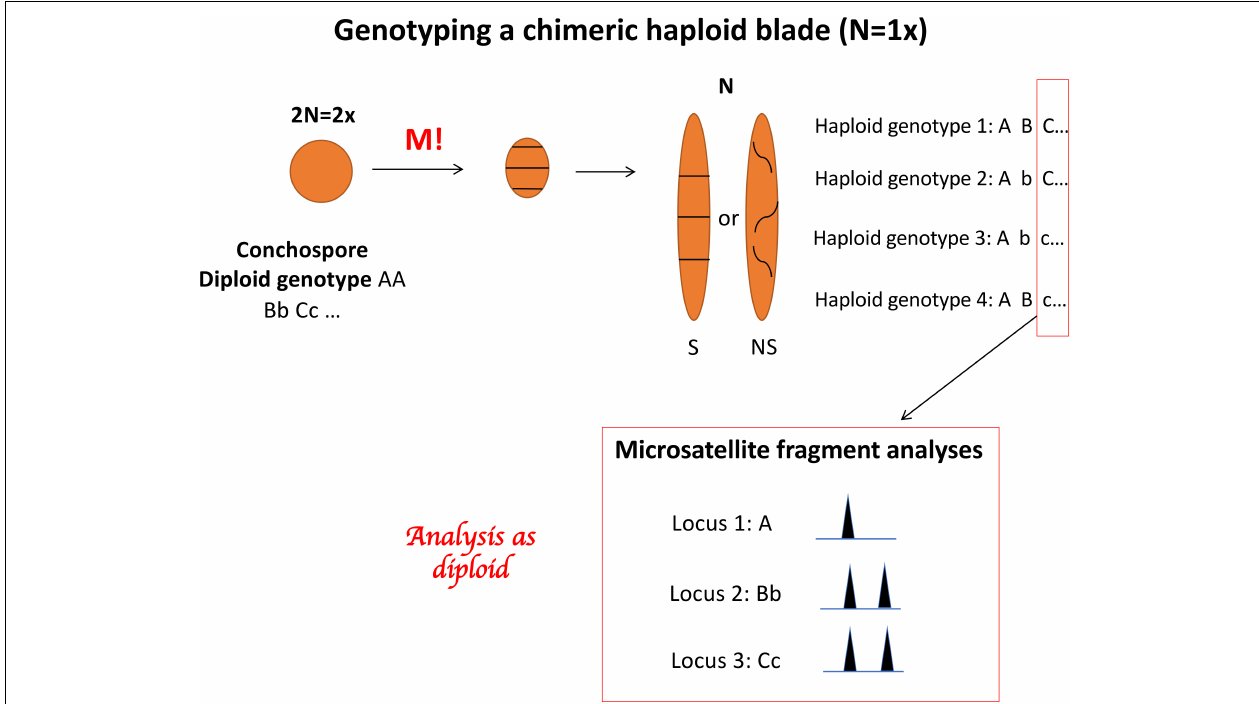
FIGURE 2 | Porphyra life cycle showing the development of the conchospore into a chimeric haploid blade with 4 genotypes spreading along the blade, and the genotyping with three microsatellite loci displaying a multiple allele genotypes in the haploid